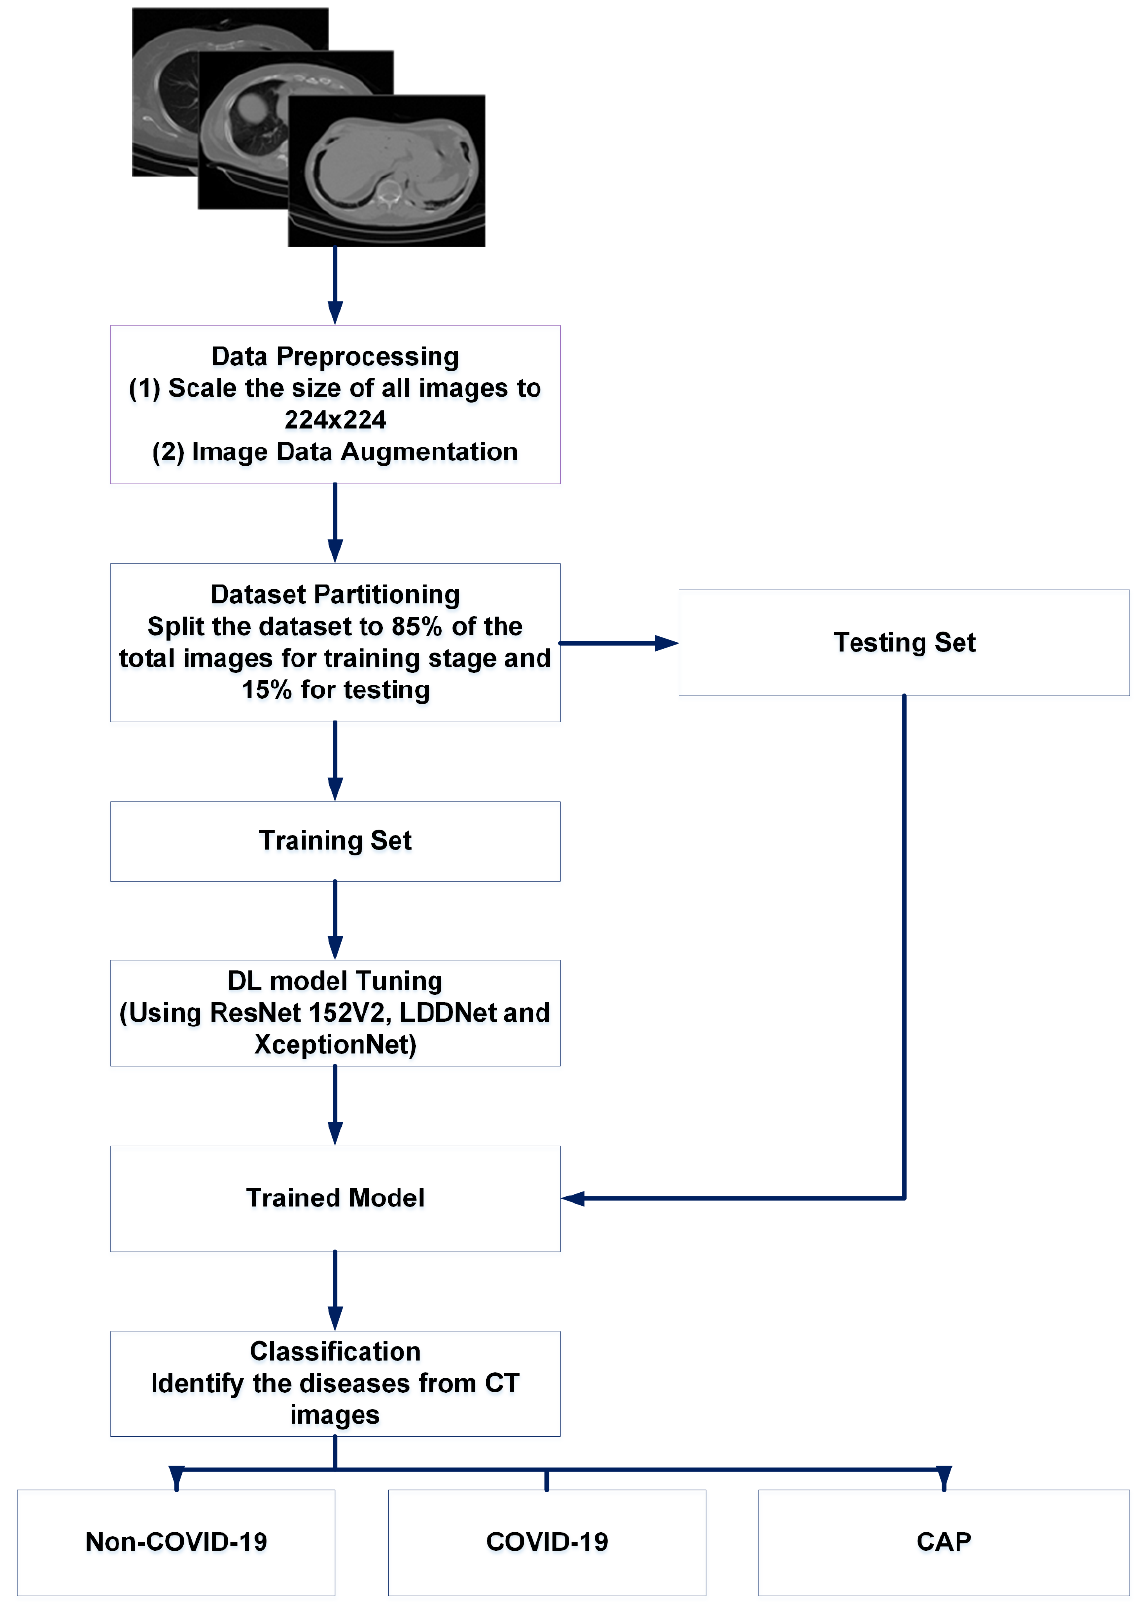
Figure 3. Basic summary of our proposed work for CT scan images.